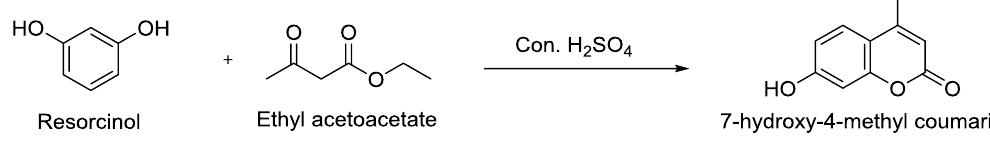
Figure 6. Reaction scheme for the synthesis of 7-hydroxy-4-methyl